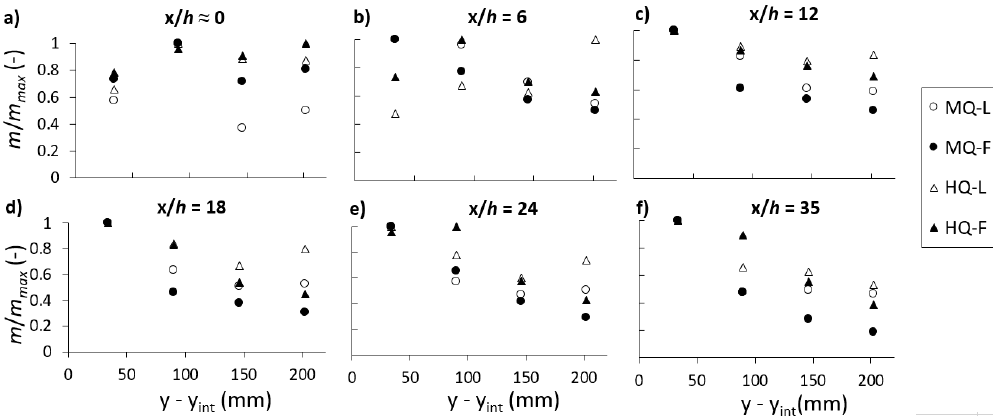
Figure 13. Lateral profiles of net deposition per unit area m normalized with the maximum net deposition m max for the developing region of the flow ( x < L t ) for six positions of increasing distance from the interface of the main channel–vegetation: ( a ) at x/ h ≈ 0, ( b ) at x/ h = 6, ( c ) at x/ h = 12, ( d ) at x/ h = 18, ( e ) at x/ h = 24, and ( f ) at x/ h = 35. MQ = medium flow rate (50 L/s); HQ = high flow rate (83 L/s); L = leafless; F = foliated.